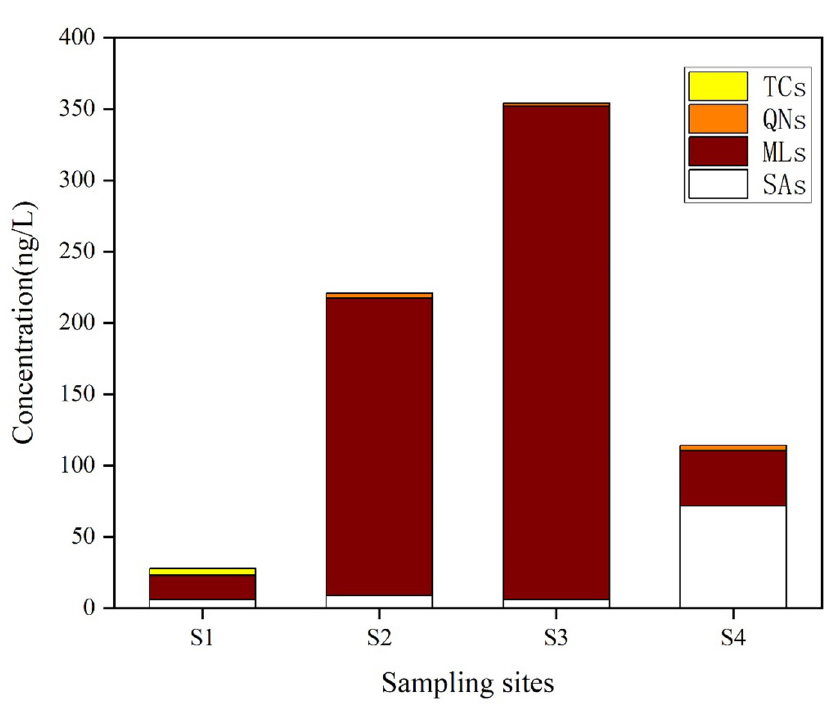
Fig 4. Concentrations of detectable antibiotics from four categories in the sampling sites from the receiving water bodies of four PMFs. Antibiotics with a detection frequency of > 70% and an average concentration of > 5.00 ng/L in this study were selected to compare surface waters at home and abroad. The target antibiotic concentrations in the waters bodies around PMFs were comparable to those in other water environments.